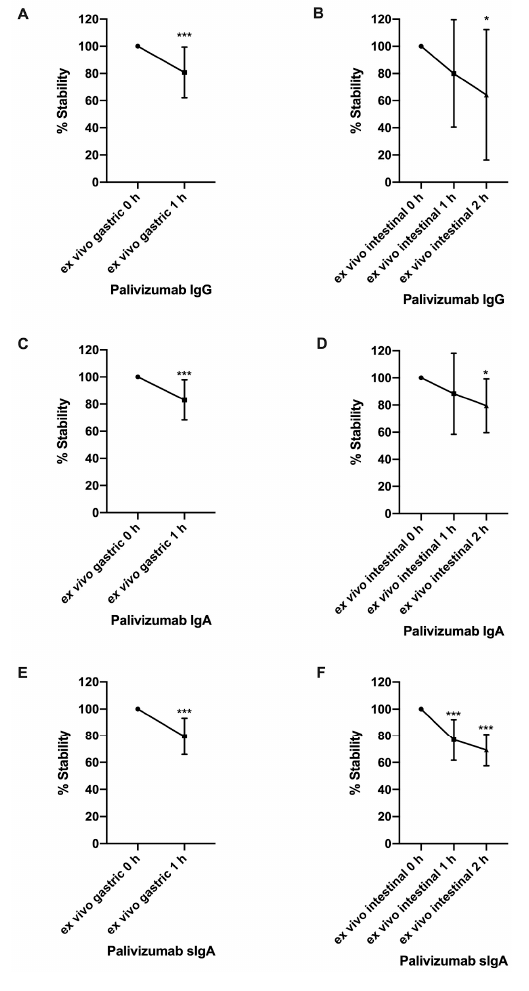
Figure 1. Percentage stability of palivizumab IgG, IgA, and sIgA across ex vivo infant digestion. ( A ) Percentage stability of palivizumab IgG, ( C ) IgA, and ( E ) sIgA across gastric digestion. ( B ) Percentage stability of palivizumab IgG, ( D ) IgA, and ( F ) sIgA across intestinal digestion. Values are mean ± SD, n = 18; three infants with two dilutions in triplicate. Asterisks represent the p -value (* p < 0.05 and *** p < 0.001) using the unpaired student’s t -tests to compare stability between gastric 0 h and 1 h samples. One-way ANOVA followed by Tukey’s multiple comparison tests were used to compare stability among intestinal 0, 1, and 2 h